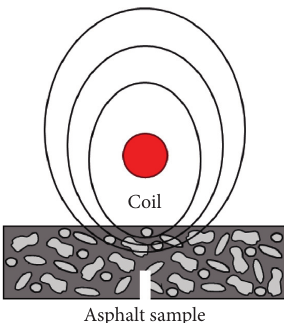
Figure 4: Schematic diagram of “skin effect” phenomenon